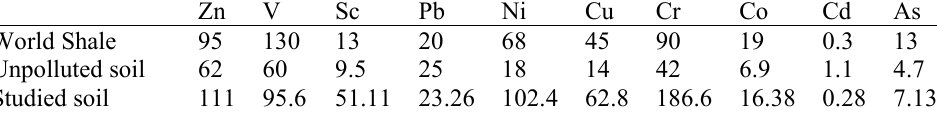
Table 2. Comparison of standard density of heavy metals in soil in studied region 11 Zn V Sc Pb Ni Cu Cr Co Cd As World Shale 95 130 Unpolluted soil Studied